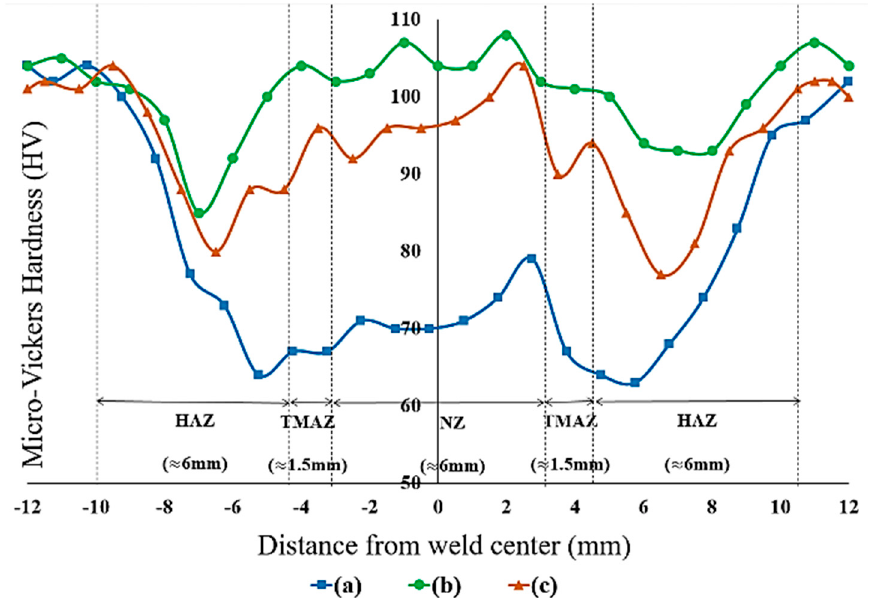
Figure 8. Hardness distribution along the centerline of the cross-section of the joints for: ( a ) Naturally aged RAFSW sample; and for artificially aged samples at: ( b ) 160 °C for 18 h; and ( c ) 220 °C for 30 min.